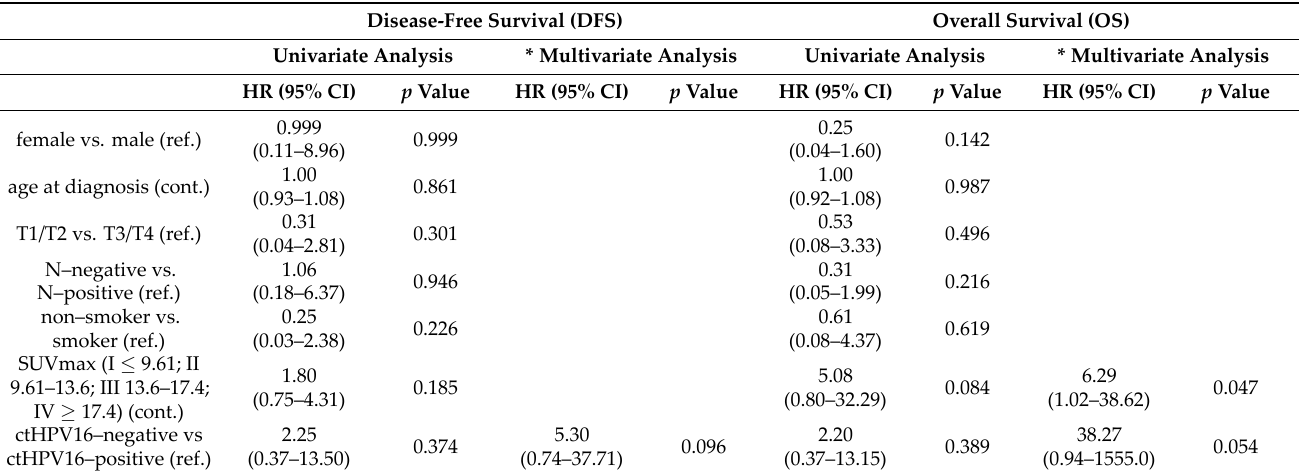
Table 3. Analysis of disease‑free survival (DFS) and overall survival (OS) in the subgroup of ASCC patients treated with CRT and known pre‑treatment status of ctHPV16 (N = 35).